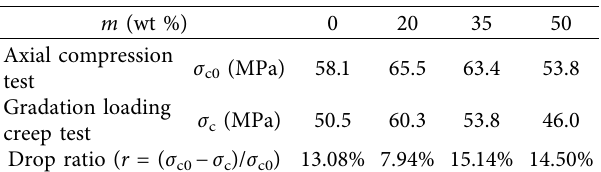
Figure 1: Mounting of strain gauges on the concrete Table 3: Creep peak stress ( σ c ) and conventional uniaxial com- pression peak stress ( σ c0 ) of concrete with different fly ash re- placement ratios ( m ).